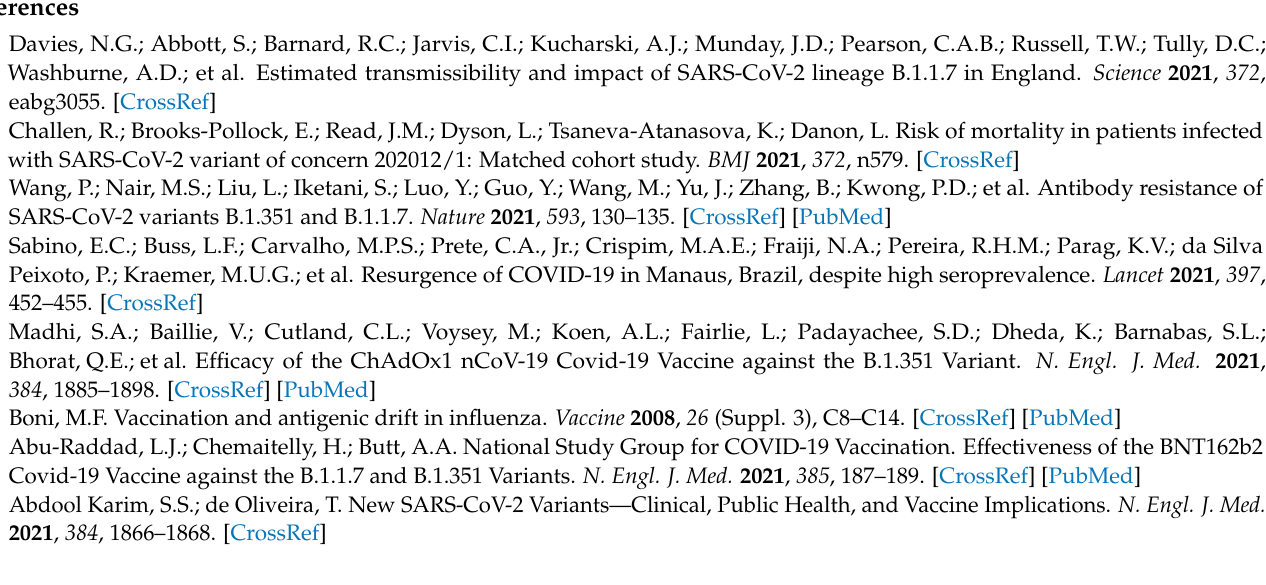
Domain, Figure S2: Direct Epitope-Paratope Matrix for RBD, Figure S3: Indirect Epitope-Paratope Matrix for RBD, Figure S4: Mutability Clustering for RBD SNPs, Figure S5: PADS-40 for RBD ER-1 and ER-3, Table S1: RBD Spectral Clustering Features, Table S2: RBD Antigenicity PCA Features, Table S3: mAb/Nanobody—RBD/NTD